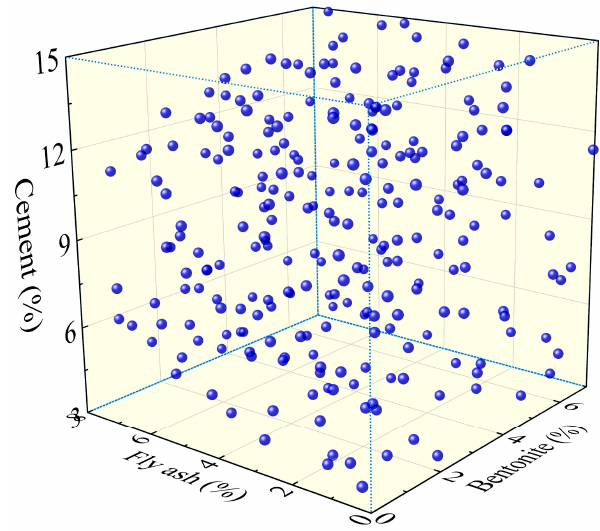
Figure 24. Experimental samples for the hyper-Latin sampling method (HLS).